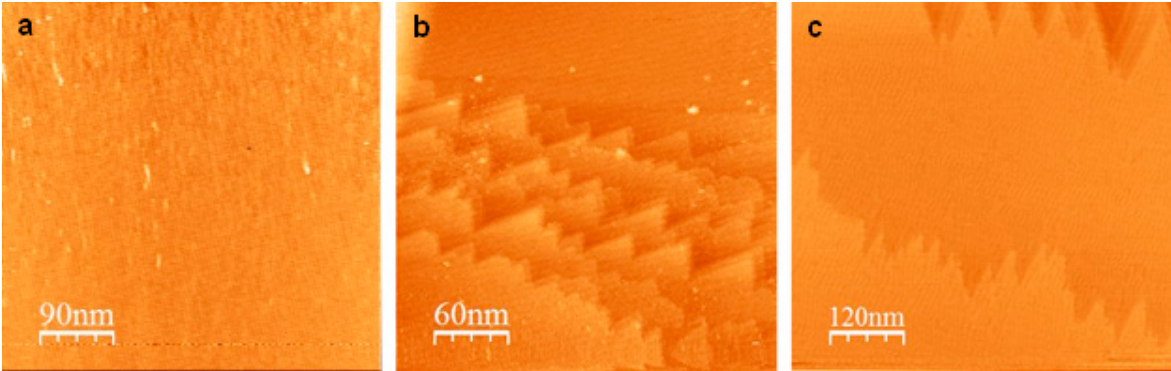
Figure A1. STM topographical images of bare Ge (110) with ( a ) 6 cleaning cycles, ( b ) 14 cleaning cycles, and ( c ) 21 cleaning cycles on a completely new sample holder using 400 eV Ar + . Imaging parameters are ( a ) 1 nA, 1 V tip bias; ( b ) 4 nA, 1.5 V tip bias; ( c ) 3 nA, 2 V tip bias.